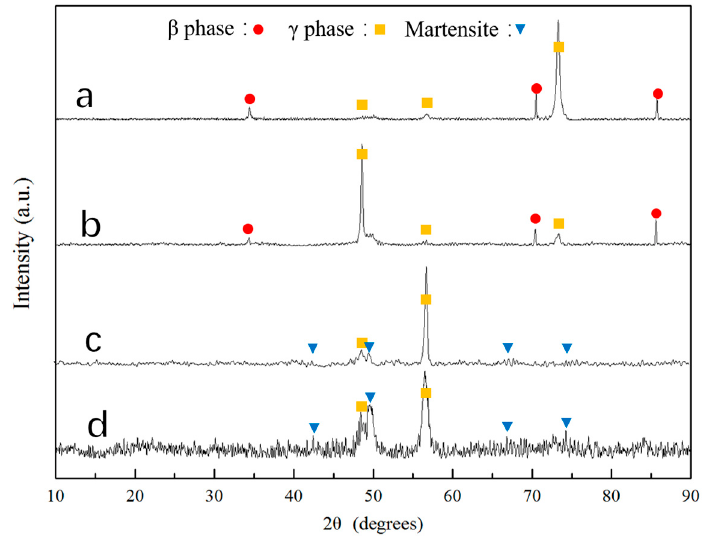
Figure 4. Room temperature XRD patterns of the Co 33 Ni 31 Al 27 Fe 9 alloy with furnace cooled and RS: ( a ) furnace cooled; ( b ) D8; ( c ) D4; and ( d ) D1.